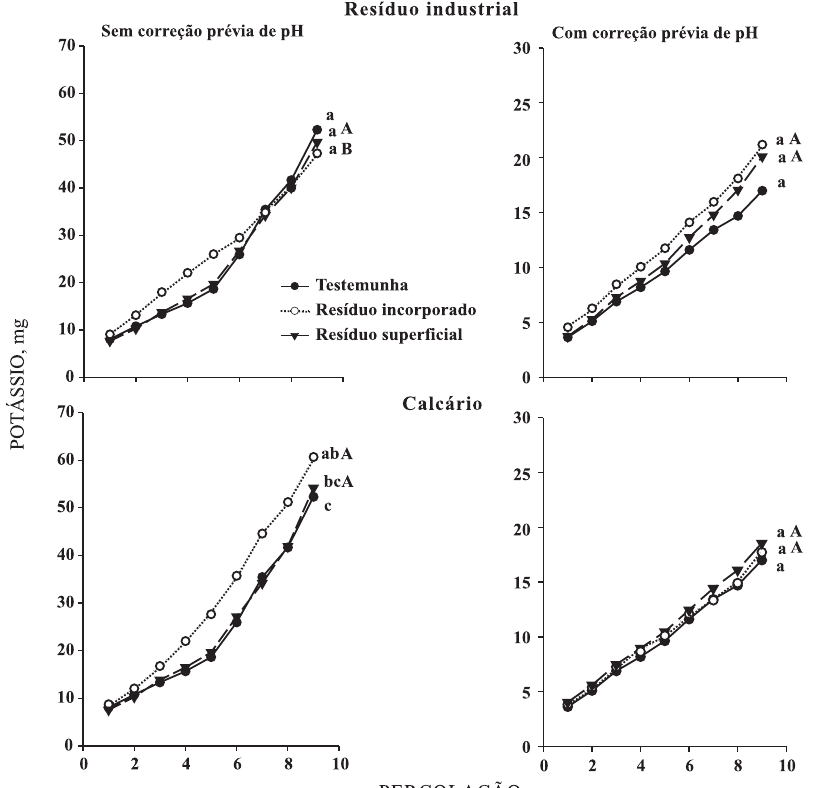
Figura 5. Perdas acumuladas de potássio após 10 percolações com água destilada em virtude da aplicação de calcário ou de um resíduo industrial em amostras de solo com e sem correção prévia de pH. (Letras minúsculas comparam as formas de aplicação de cada corretivo com a testemunha dentro de cada pH; letras maiúsculas comparam esses mesmos tratamentos entre os corretivos da acidez, dentro do